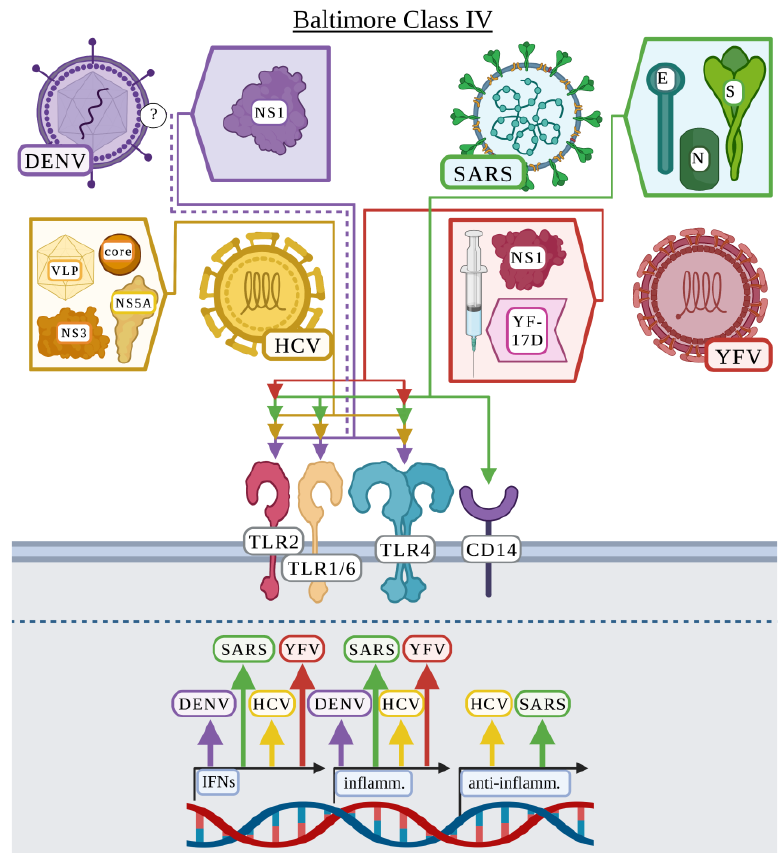
Figure 4. Baltimore Classification IV viruses recognized by surface TLRs: Baltimore Class IV include dengue viruses (DENV), hepatitis C virus (HCV), severe acute respiratory syndrome coronavirus (SARS), and yellow fever virus (YFV). All DENV serotypes were demonstrated to activate a surface TLR response. DENV was demonstrated to activate TLR2/6 and TLR4 for the induction of an inflammatory and IFN response, with NS1 being the potential ligand. HCV VLP, core, NS3, and NS5A were all demonstrated to activate different surface TLR responses including TLR2/1, TLR2/6, and TLR4 for an inflammatory, anti-inflammatory, and/or IFN response. SARS-CoV-2 ligands including S, E, and N were all demonstrated to activate an inflammatory, anti-inflammatory, and/or IFN response via TLR2/1 or TLR2/6 and TLR4. YFV NS1 activated an IFN response, and both the attenuated vaccine (indicated by the needle and syringe), YF-17D and NS1 activated an inflammatory response. Early HCV surface TLR recognition studies focused on HCV core protein and NS3, which activated TLR2, but not TLR4, and signaling was MyD88-dependent [17,20–22]. While TLR2 was not necessary for the internalization of these proteins, TLR2 activation was nec- essary for the production of TNF, IL-6, and IL-8 in different mammalian cells [17,20–22]. Both Chung et al. and Swaminathan et al. suggest that HCV core protein via TLR2 sig- naling may increase host susceptibility to microbial infection [20] and HIV infection [21].